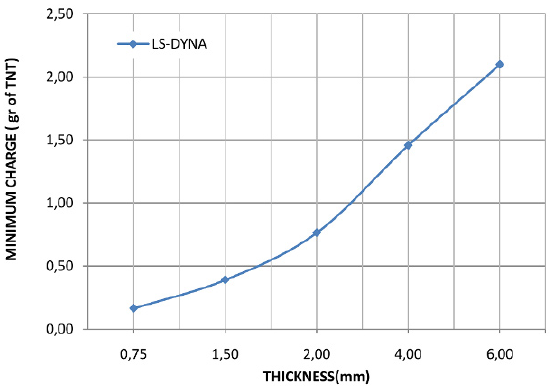
Figure 12. Minimum simulated charges for 100 mm diameter.